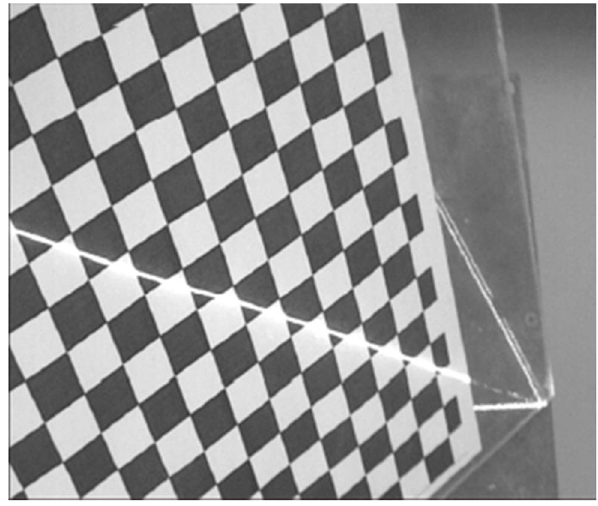
Figure 2. The imaging of light stripe on the checker board.